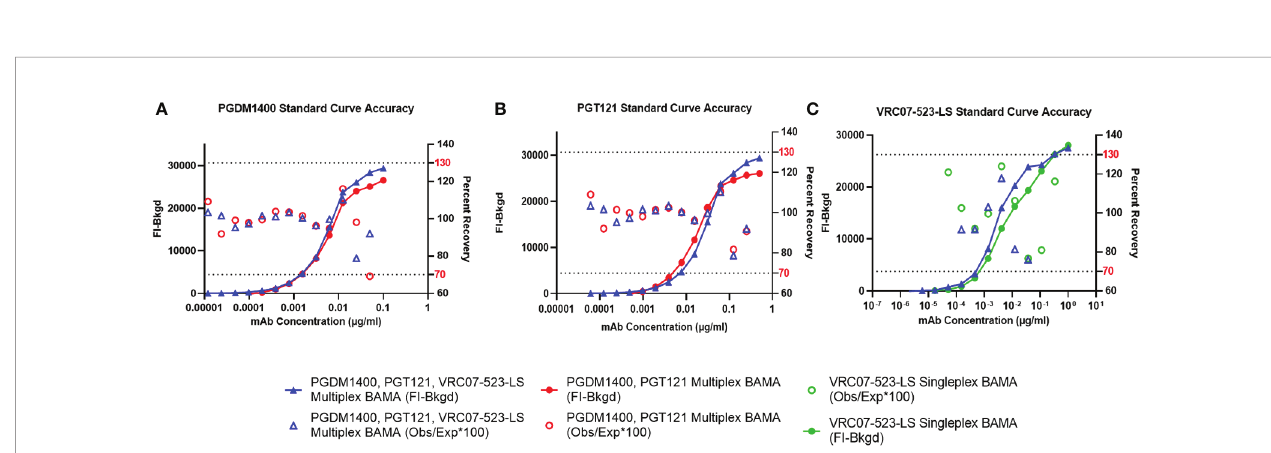
FIGURE 5 | Accuracy of the PGDM1400/PGT121/VRC07-523-LS Triplex PK standard curves in diluent and HIV-1 seronegative human serum. PGDM1400 (A) , PGT121 (B) and VRC07-523-LS (C) were co-titrated in assay diluent and 1:100 HIV-1 seronegative serum diluted in assay diluent. 5PL EC50 values of each mAb fell within 3 standard deviations of the historical mean (solid black line).